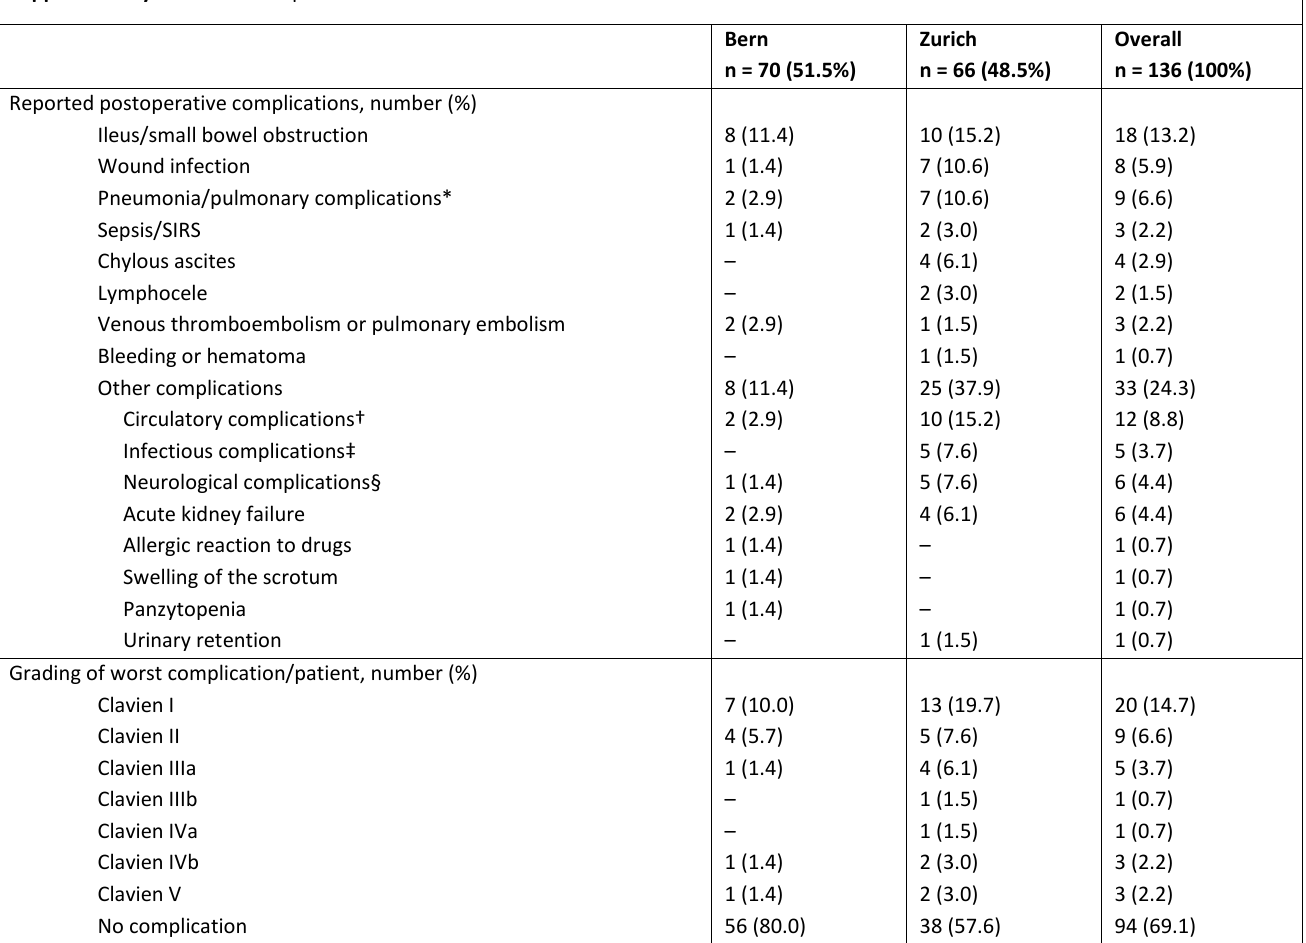
Supplementary table 7.2. Complications after